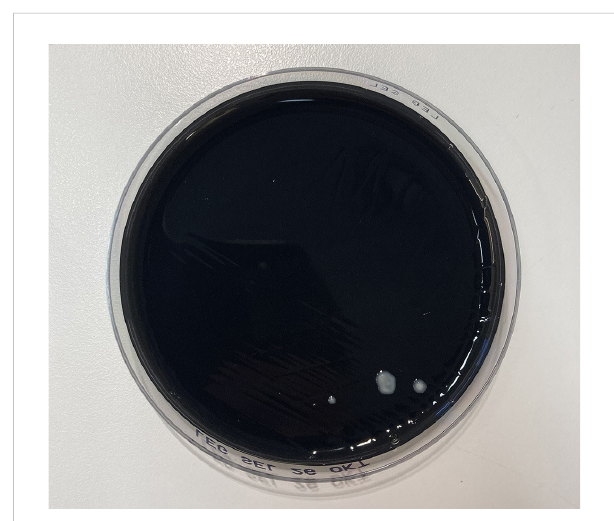
FIGURE 2 A total of fi ve colonies of Legionella longbeachae colonies grew on buffered charcoal yeast extract agar